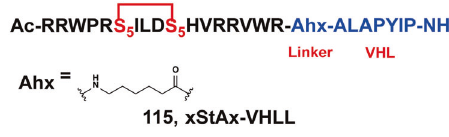
Fig. 27 The representative PROTAC targeting β